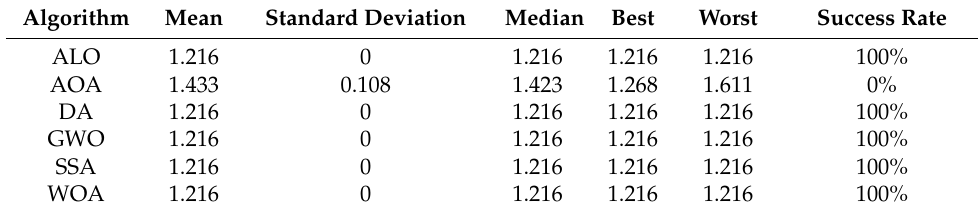
Figure 3. Convergence of optimum WR with respect to iterations. Table 3. Statistical summary of 10 trials in optimizing WR .